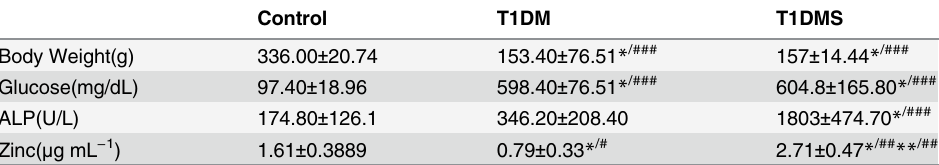
Table 1. Biochemical analyses and body weight of control, diabetic, and diabetic plus zinc supple- mentation groups. Control